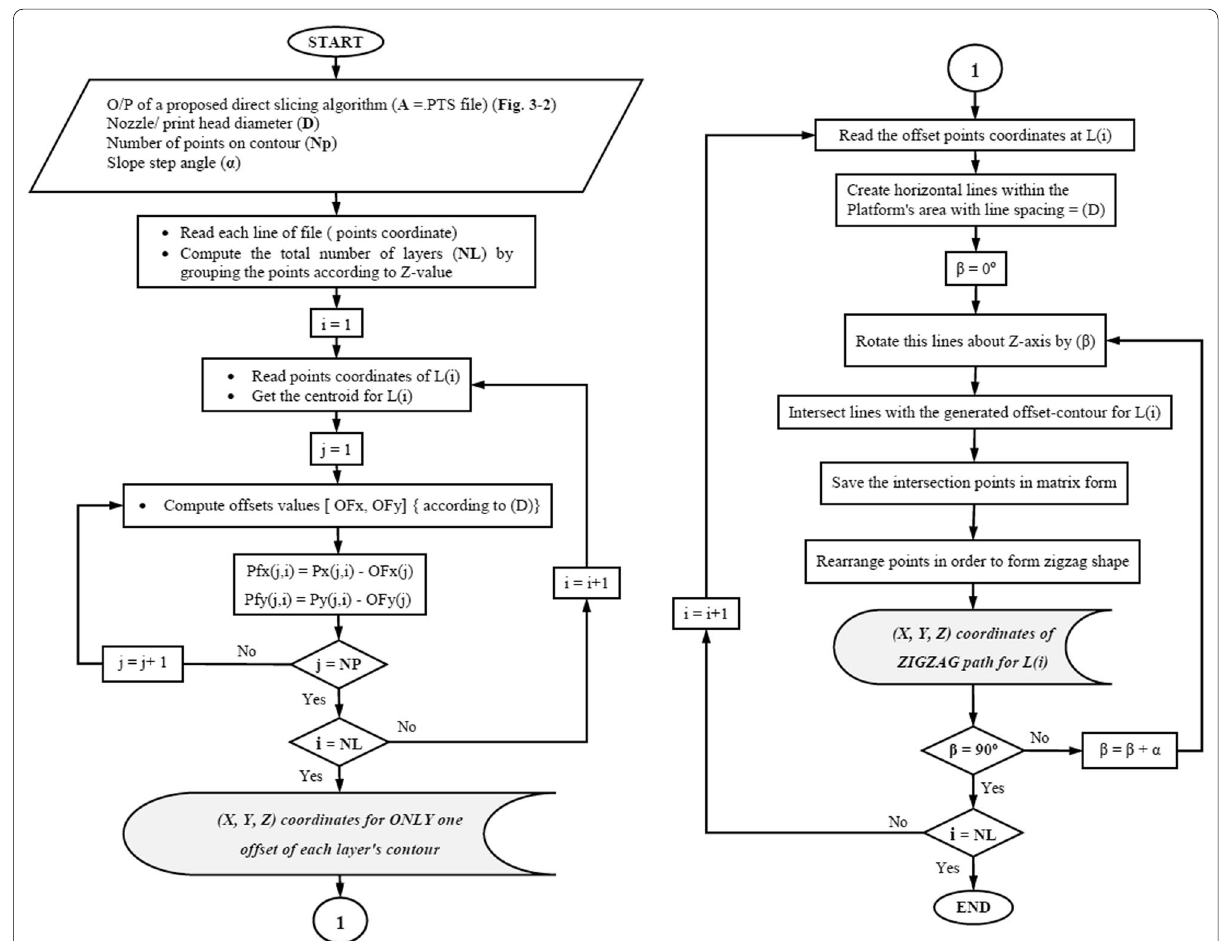
Fig. 14 Flowchart of the proposed zigzag tool-path